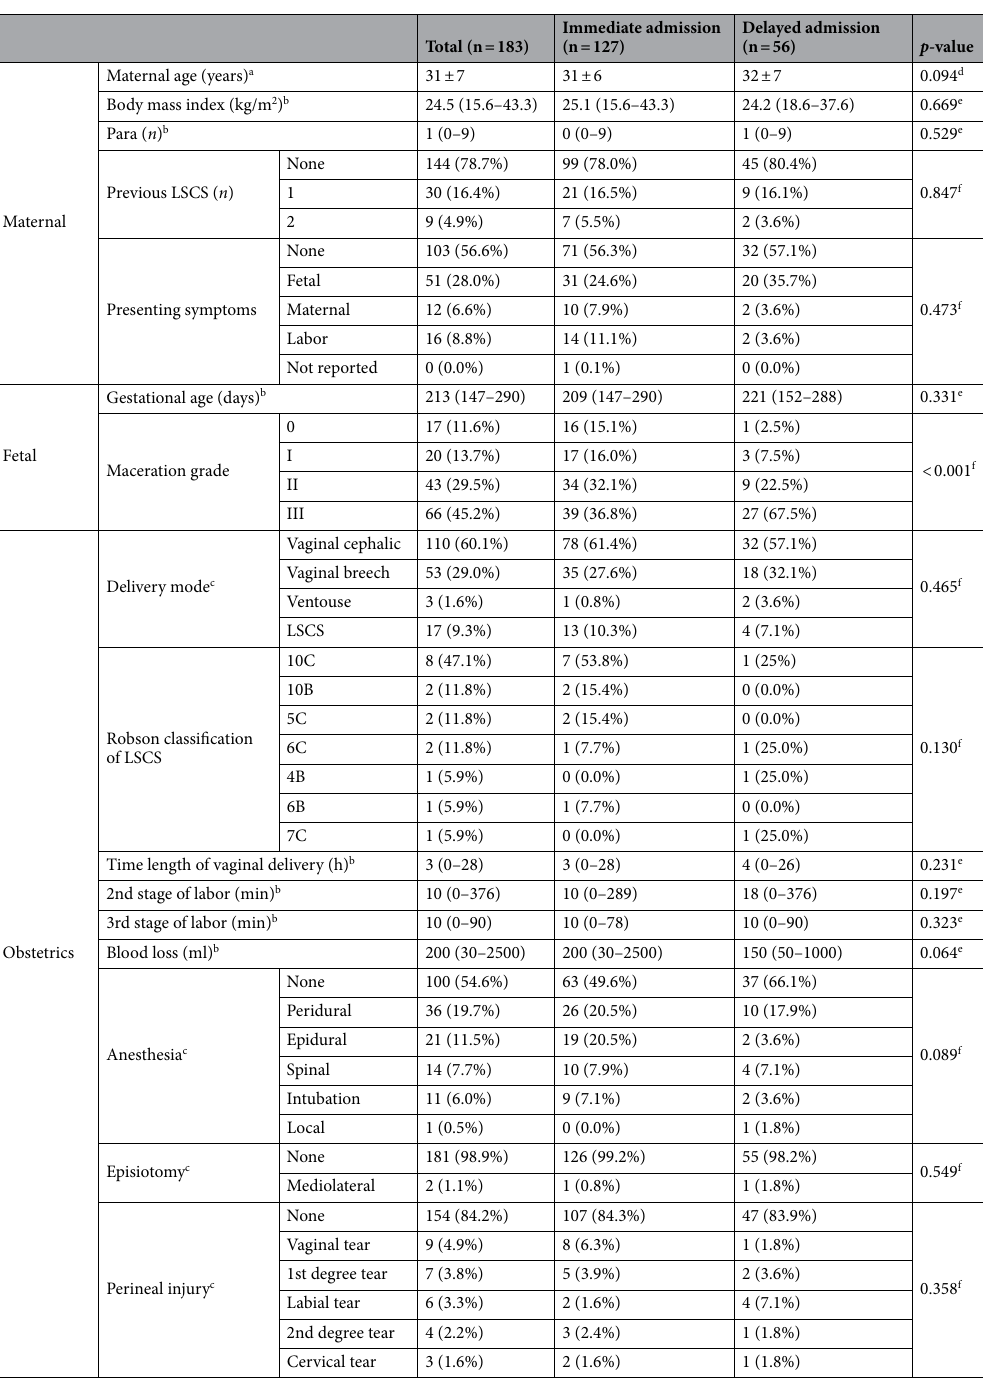
Table 2. Comparison of fetomaternal characteristics and obstetric variables after stillbirth delivery between immediate and delayed admission groups. LSCS lower segment caesarean section. a Mean ± Standard